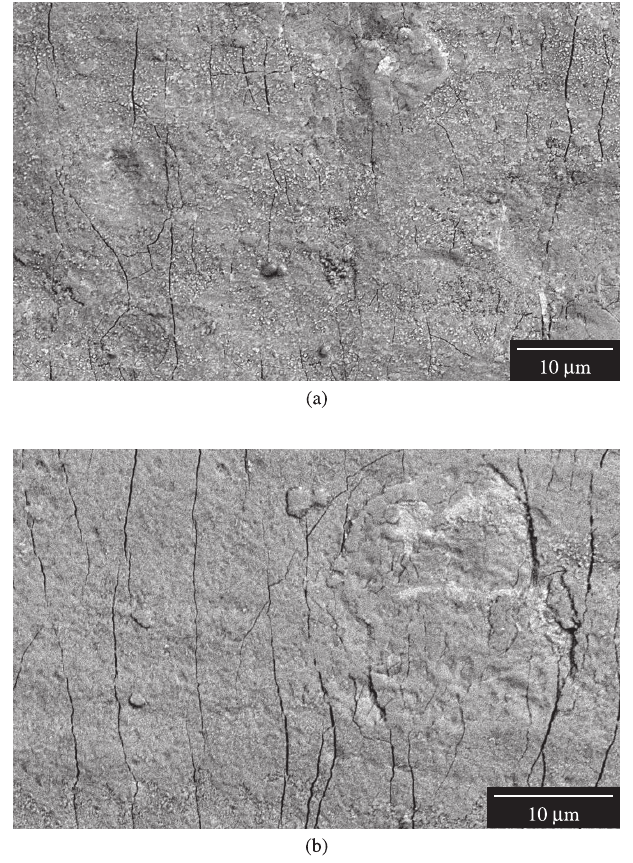
Figure 3. Image of top views of the a) A1 sample (ISC at 12%; oil flow at +30%; slab thickness = 28 mm); and b) A5 sample (ISC at 12%; oil flow at –30%; slab thickness = 28 mm) in